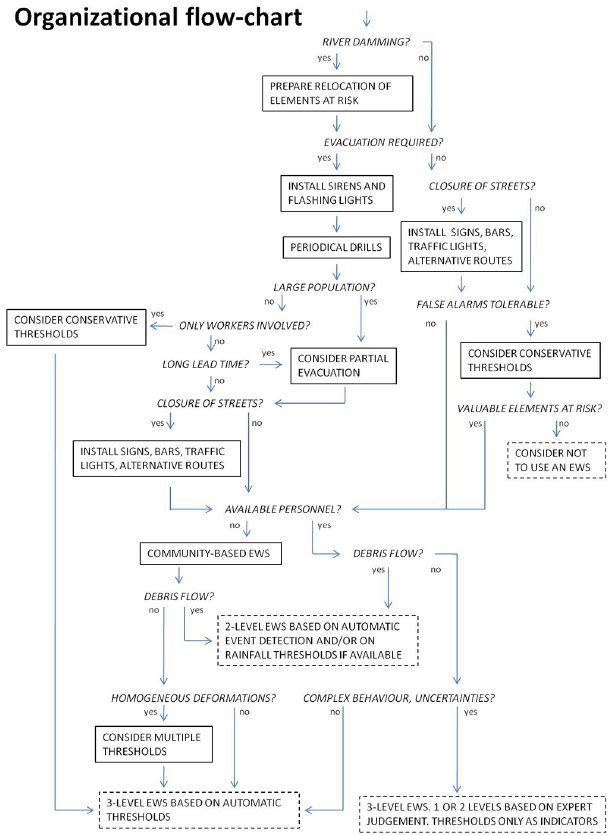
Fig. 3. Flow chart-based toolbox for the choice of organizational features in slope scale